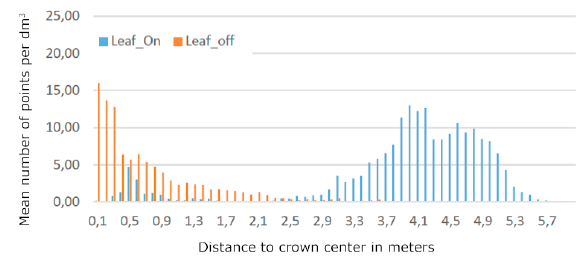
Figure 5. Mean point density per 5x1 dm 3 in various distances to the crown centre in level 3,5 - 4 m height.